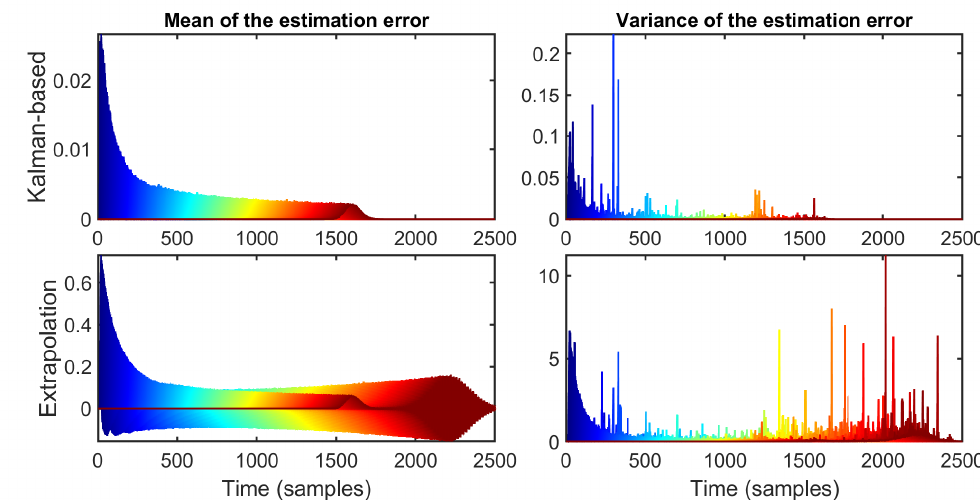
( k ) and variance σ 2 ( k ) of the estimation error for h = 4, p = 0.75, and Figure 18. Mean µ ε ε i i M = 400 vehicles. Here, the mean and variance of the Kalman-based strategy show a smaller am- plitude in comparison to the extrapolation strategy. Additionally, the mean of the latter exhibits string-unstable behavior, as shown in the last vehicles of the